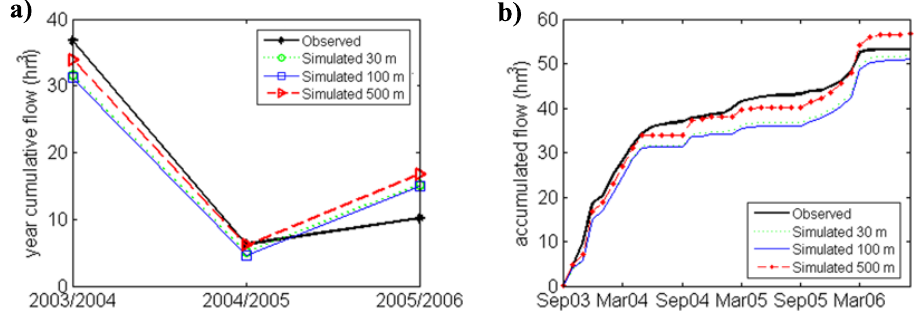
Fig. 4. (a) Observed and simulated annual runoff during the study period, and (b) observed and simulated total